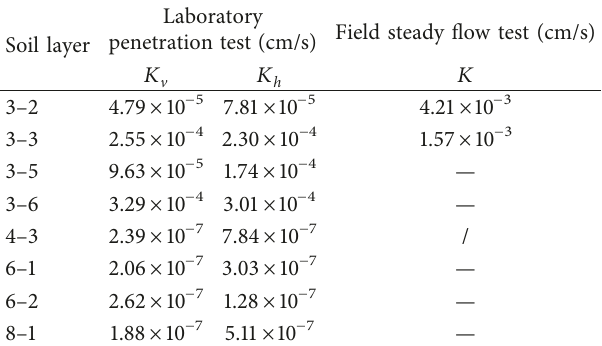
Figure 4: Soil profile and geotechnical parameters. Table 1: Laboratory penetration test and field steady flow